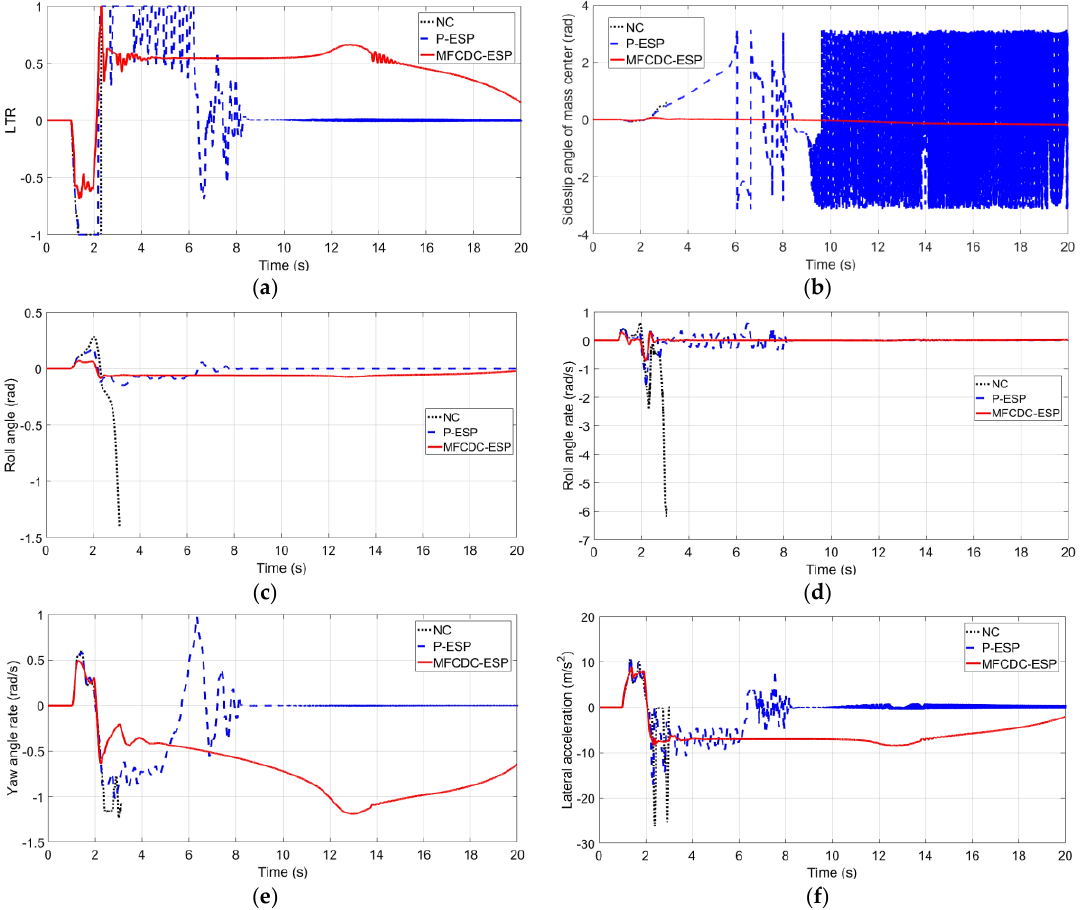
Figure 12. Main results of fishhook test. The result of NC is expressed with a black dotted line; the result of P-ESP is expressed with a blue chain line; the result of MFCDC-ESP is expressed with a red solid line. ( a ), ( b ), ( c ), ( d ), ( e ), and ( f ) are the comparison for LTR, vehicle sideslip angle, roll angle, roll angle rate, yaw angle rate, and lateral acceleration, respectively.